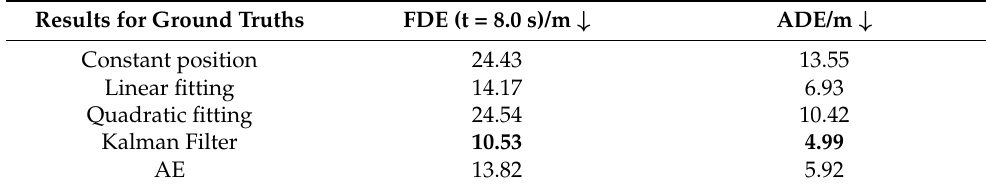
Table 3. Prediction performance for labelled ground truth inputs. Results for Ground